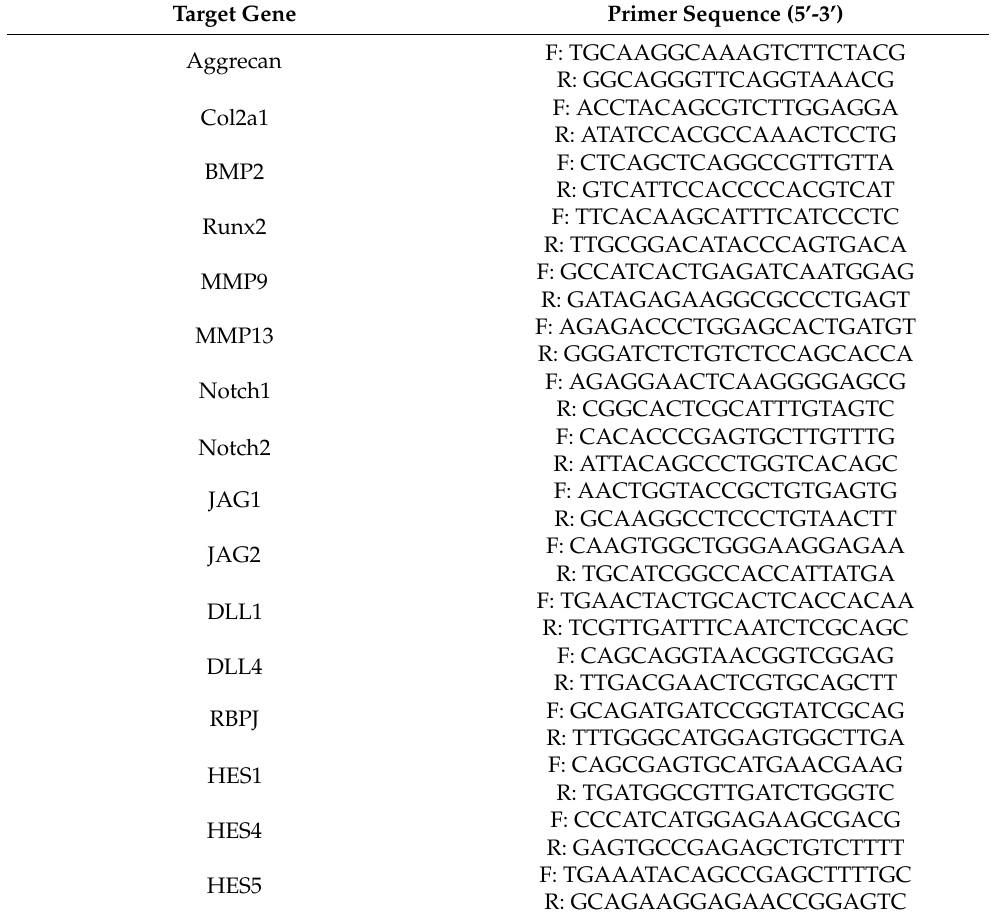
Table 1. Sequences of primers used to amplify specific mRNAs by